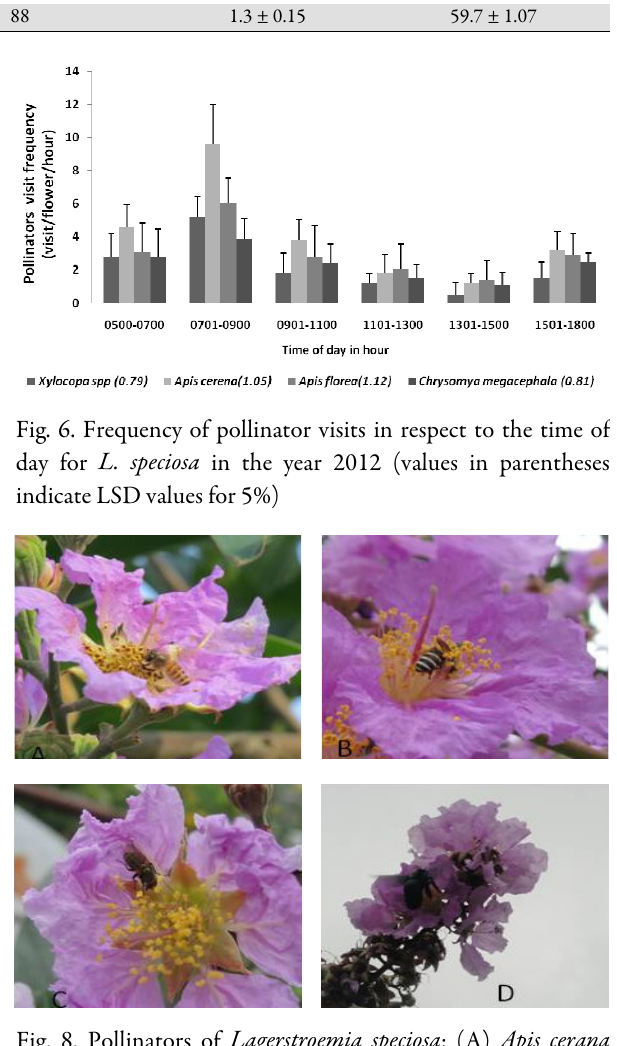
Fig. 8. Pollinators of Lagerstroemia speciosa ; (A) Apis cerana (Indian Hive bee); (B) Apis florea (Little bee); (C) Chrysomya megacephala ; (D) Xylocopa spp. (Carpenter